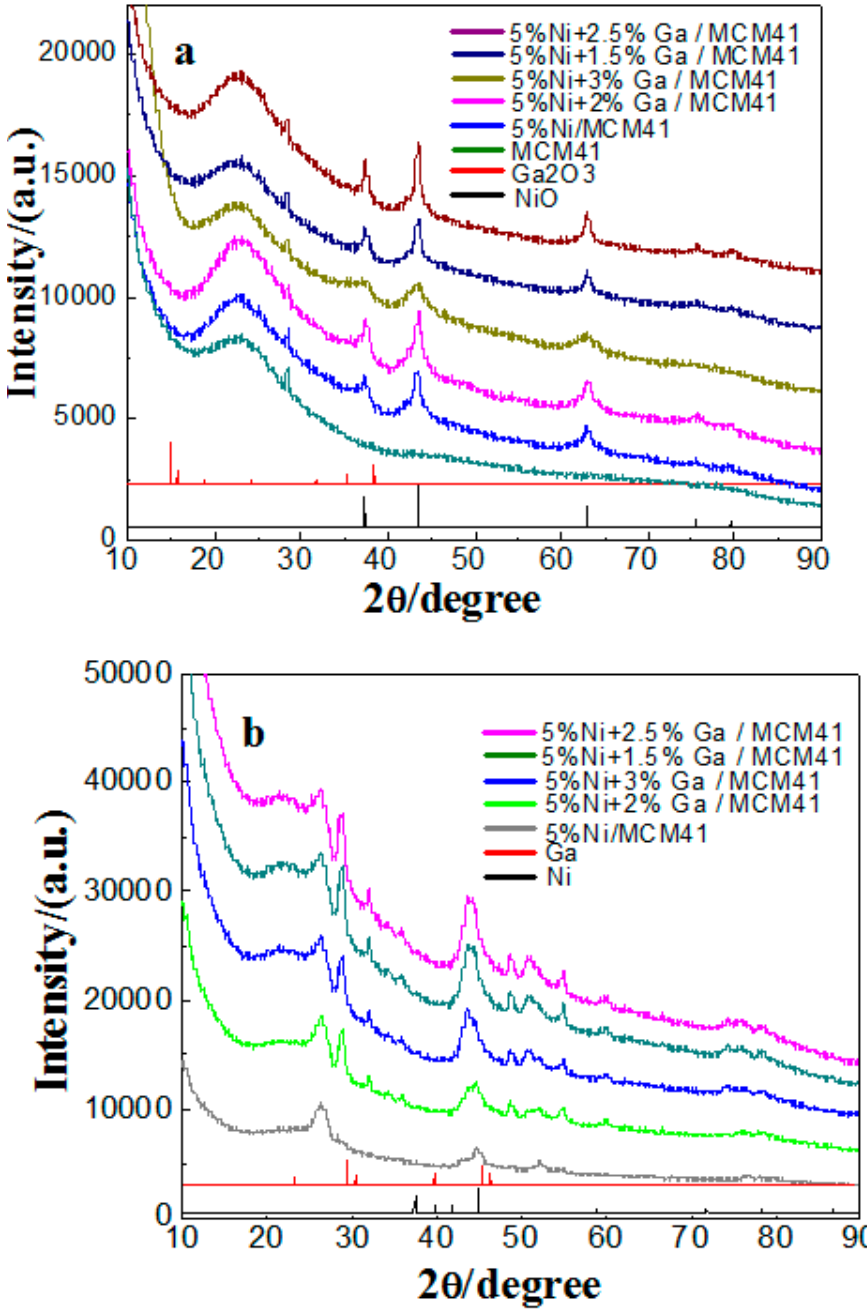
Figure 2. XRD patterns of ( a ) fresh and ( b ) used: 5%Ni+x%Ga/MCM-41 (x = 0, 1.5, 2.0, 2.5, 3.0) catalysts.